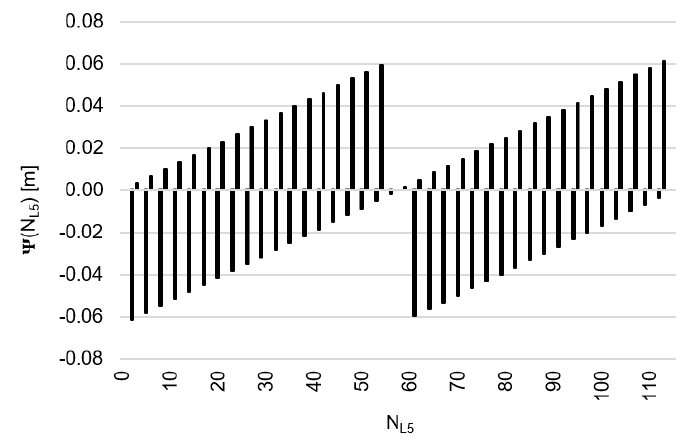
< − 62; + 62 mm > N L 5 N L 1 (m), for values from interval (m), for values from interval < −62; + 62 mm > . (cid:3261)(cid:3121) (cid:3015) (cid:3261)(cid:3117)